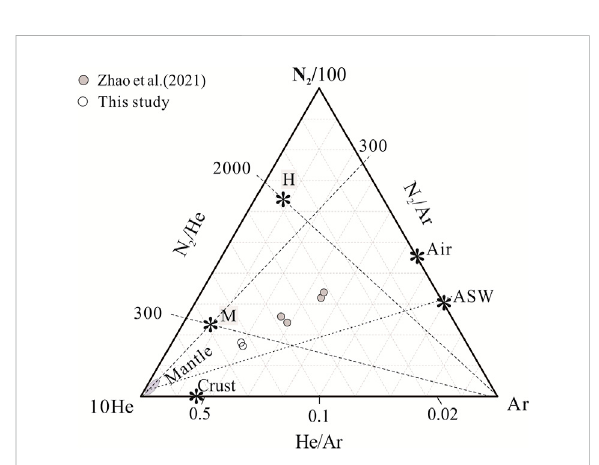
FIGURE 5 DiagramofHe – Ar – N 2 concentrationsofthehotspringgases in the Arxan volcanic region, M - magmatic source; H - hydrothermal source (Taran,